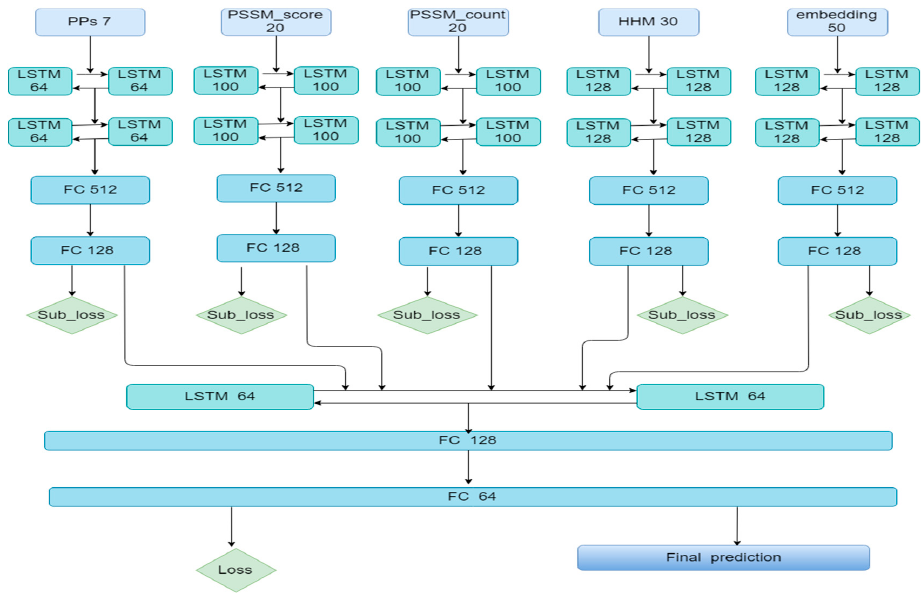
Figure 1. The ensemble model based on Bi-LSTM.